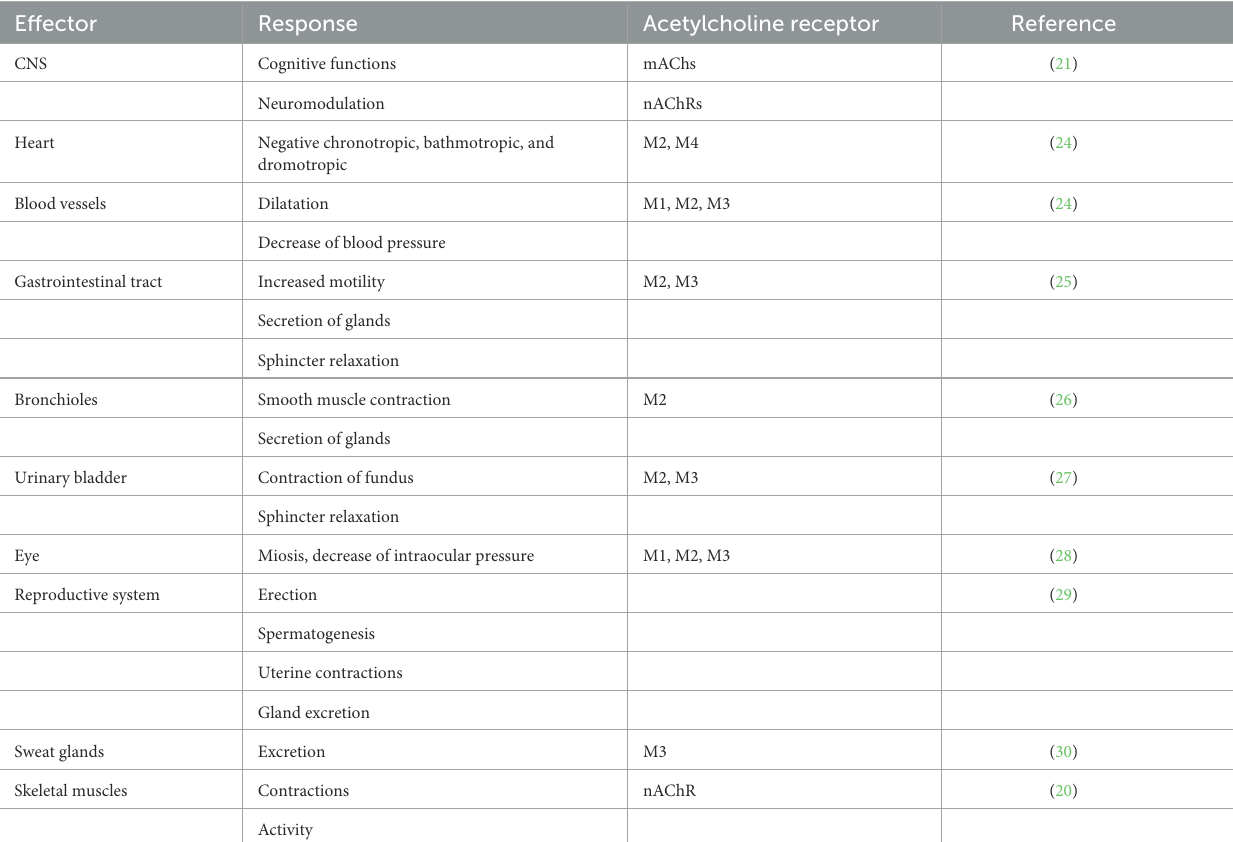
TABLE 1 Effects on various organs of the stimulated cholinergic